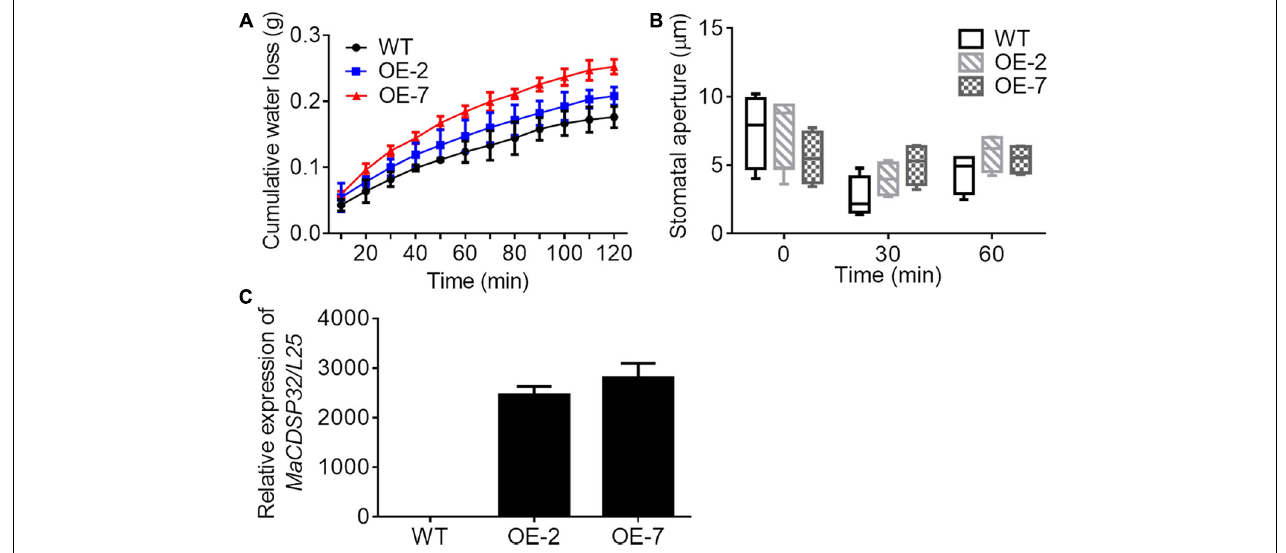
FIGURE 4 | Gene overexpression of MaCDSP32 increases water loss under dehydration conditions in transgenic tobacco. (A) The accumulated water loss of detached leaves under natural desiccation. (B) Stomatal aperture of leaves after 0, 30, and 60 min under natural desiccation. (C) Detection of MaCDSP32 gene expression in transgenic tobacco. WT, wild-type tobacco ( N. benthamiana ); OE-2 and OE-7, two transgenic tobacco lines with MaCDSP32 overexpression. At least three biological replicates were included. No significant difference was observed between the transgenic and WT